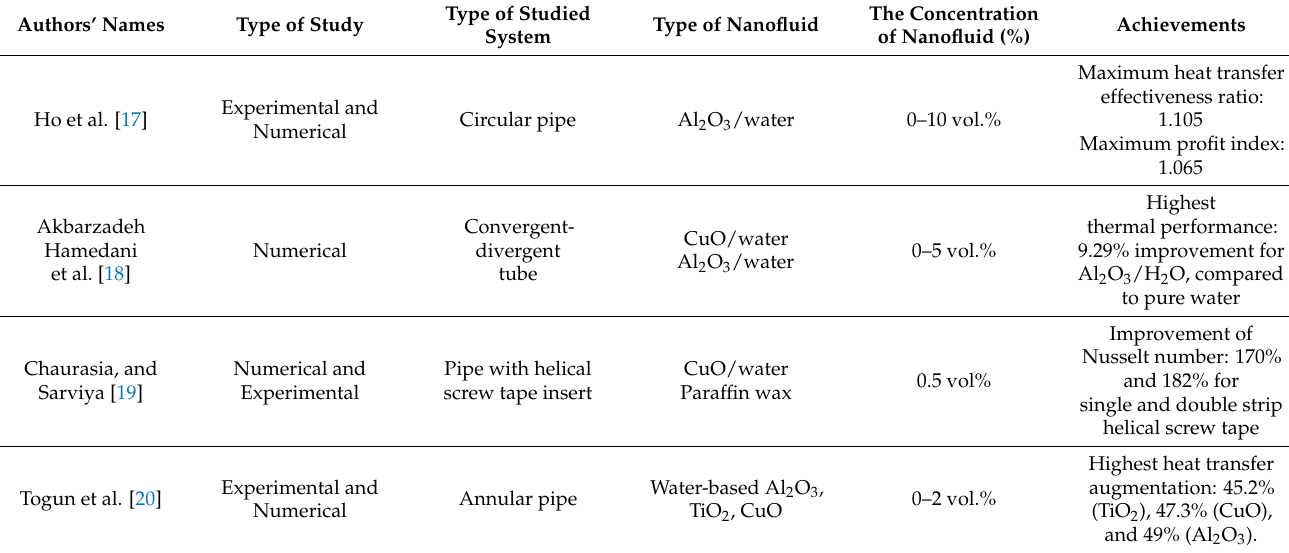
Table 1. Nanofluid heat transfer performance in heat pipe